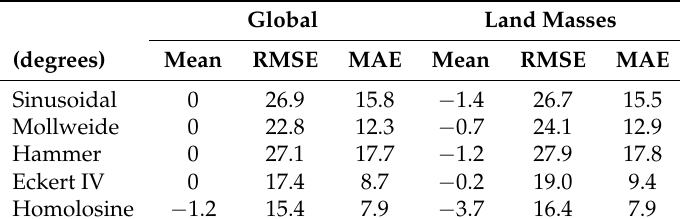
Table 3. Statistics for absolute angular distortions distributions.